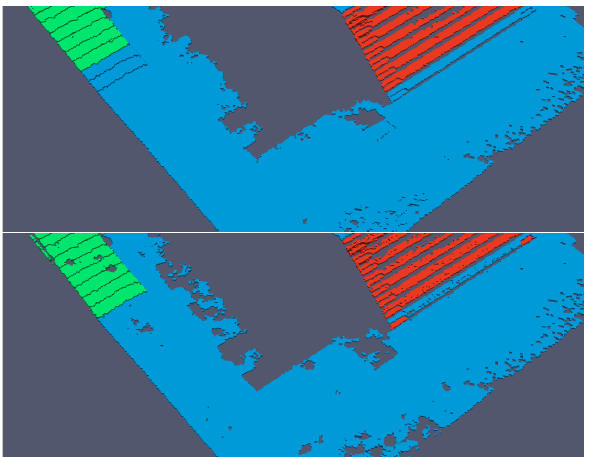
Figure 8. The regions of figure 4 (above) and the final navigable voxel space (below)